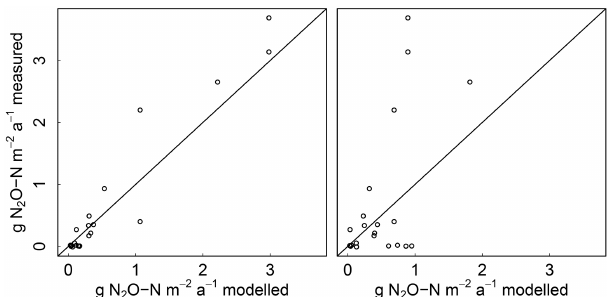
Figure 6. Fuzzy model results for calibration and cross validation for N 2 O fluxes from forest sites on organic soils. The modelled fluxes ( x axis) represent the mean flux rates from a model ensemble of 50 individually bootstrapped models. The cross validation was performed by excluding one site per iteration.